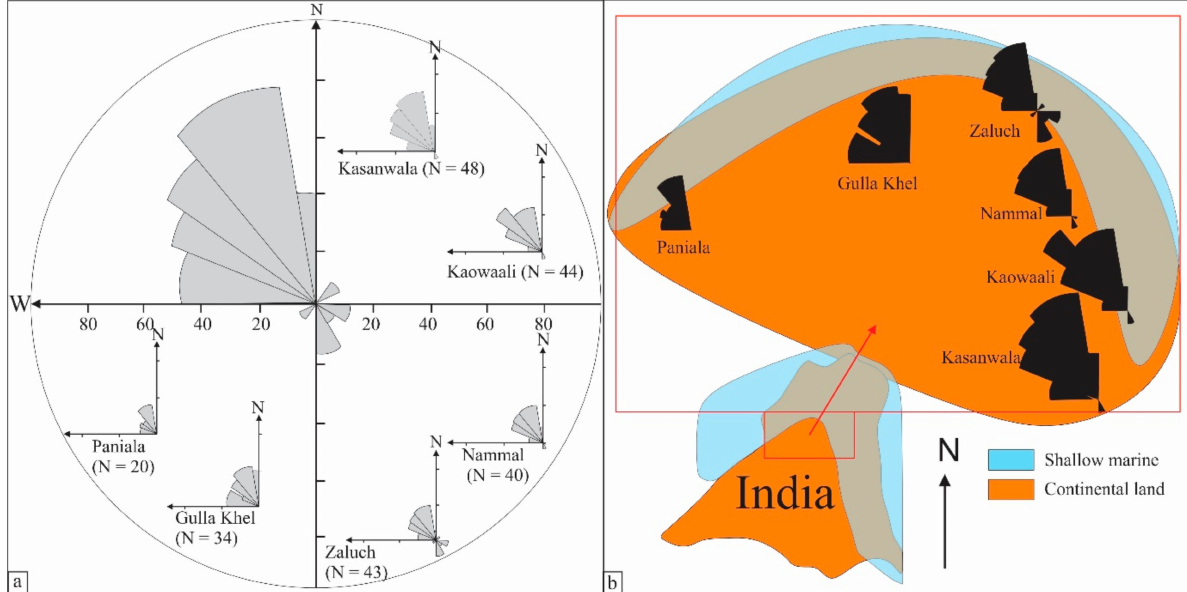
Figure 5. ( a ) Restored palaeoflow data from cross-strata favouring a north-northwestward palaeo-flow. The number of readings (N) is indicated for each section on the horizontal axis (total 229). Both the rotation of the Indian Plate and tilt of the strata are considered for the palaeoflow restoration. ( b ) Palaeoflow data plotted on the palaeogeographic map of the area (locations are tentative and not to the scale)